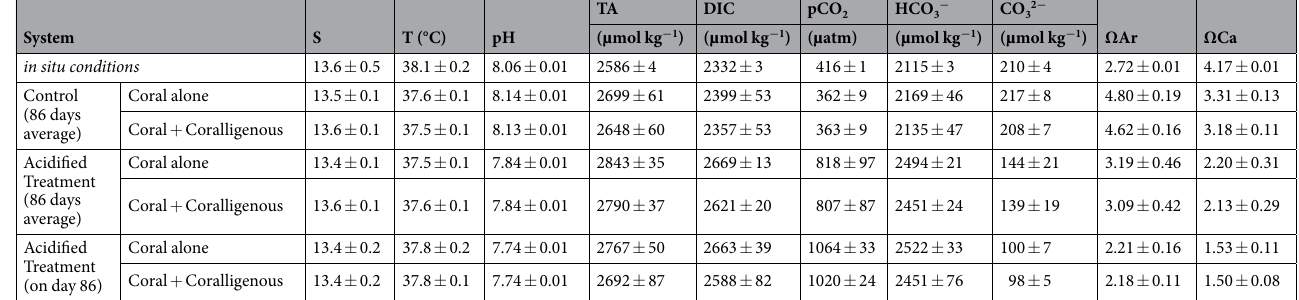
Table 1. Physical-chemical variables and main carbonate parameters measured in situ and in control or acidified treatments. For the controls and acidified treatments, reported are salinity (S); temperature (T); total alkalinity (TA); dissolved inorganic carbon (DIC); partial pressure of carbon dioxide (pCO 2 ); bicarbonates concentration (HCO 3 − ); carbonates concentration (CO 32 − ); aragonite saturation state (Ω Ar ); calcite saturation state (Ω Ca